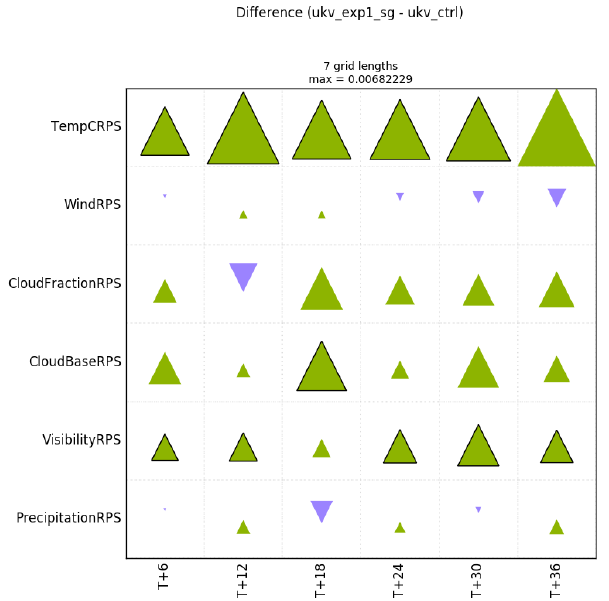
Figure 5. HiRA summary scorecard at 10.5km (seven grid lengths) spatial scale for UKV case studies run with the Leonard